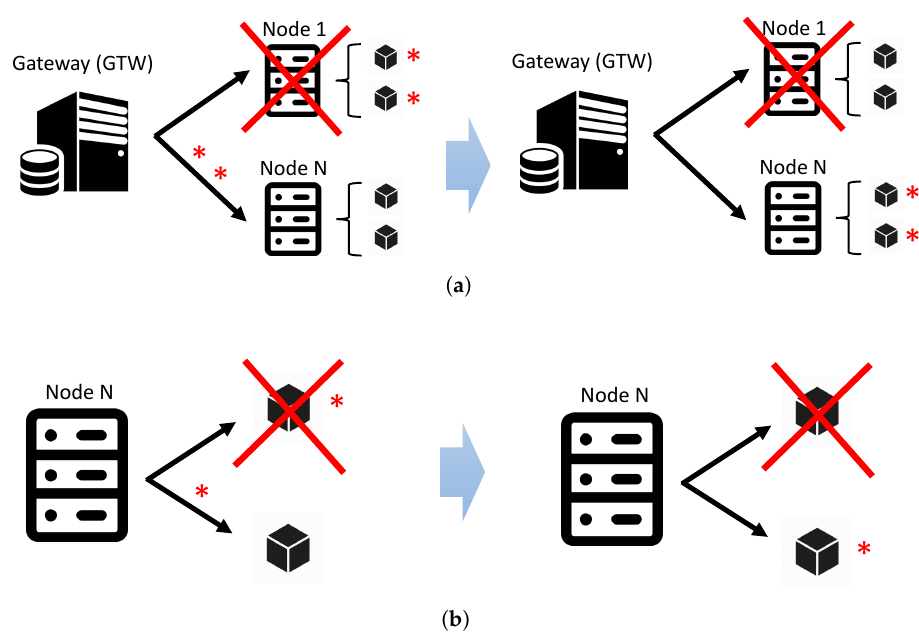
Figure 2. Data forwarding policies in the case of fog node and VM failures. ( a ) Scenario A: Node fail or all VMs fail; ( b ) Scenario B: One VM